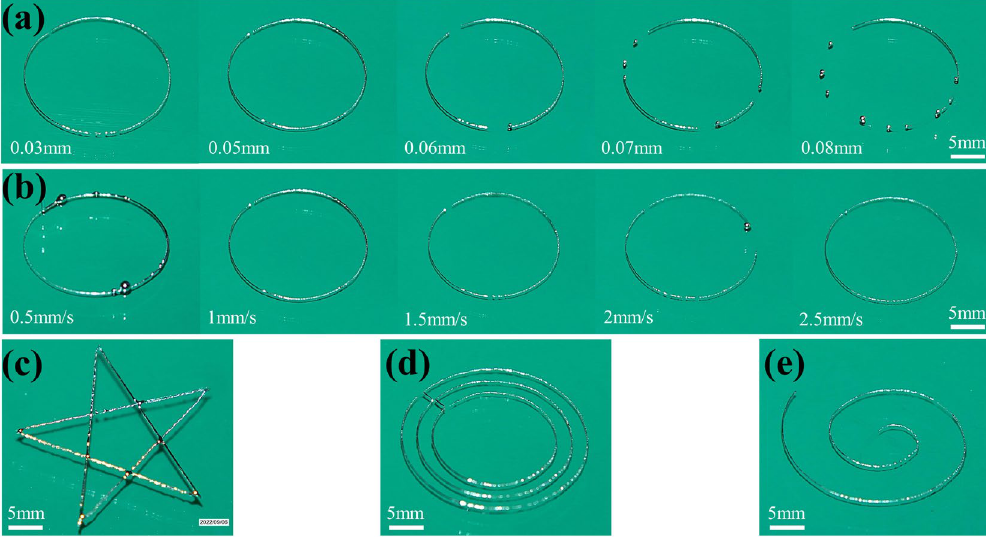
Figure 8. 3D printing experiment of EGaIn driven by micro-vibration. ( a ) Printing track using various nozzle heights, printing speed: 1 mm/s. Vibration variable: 80 V, 400 Hz, 24 g. ( b ) Printing track using various printing speeds, nozzle height: 0.05 mm. Vibration variable: 80 V, 400 Hz, 24 g. ( c ) Five-pointed star. ( d ) Concentric circle. ( e ) Spiral